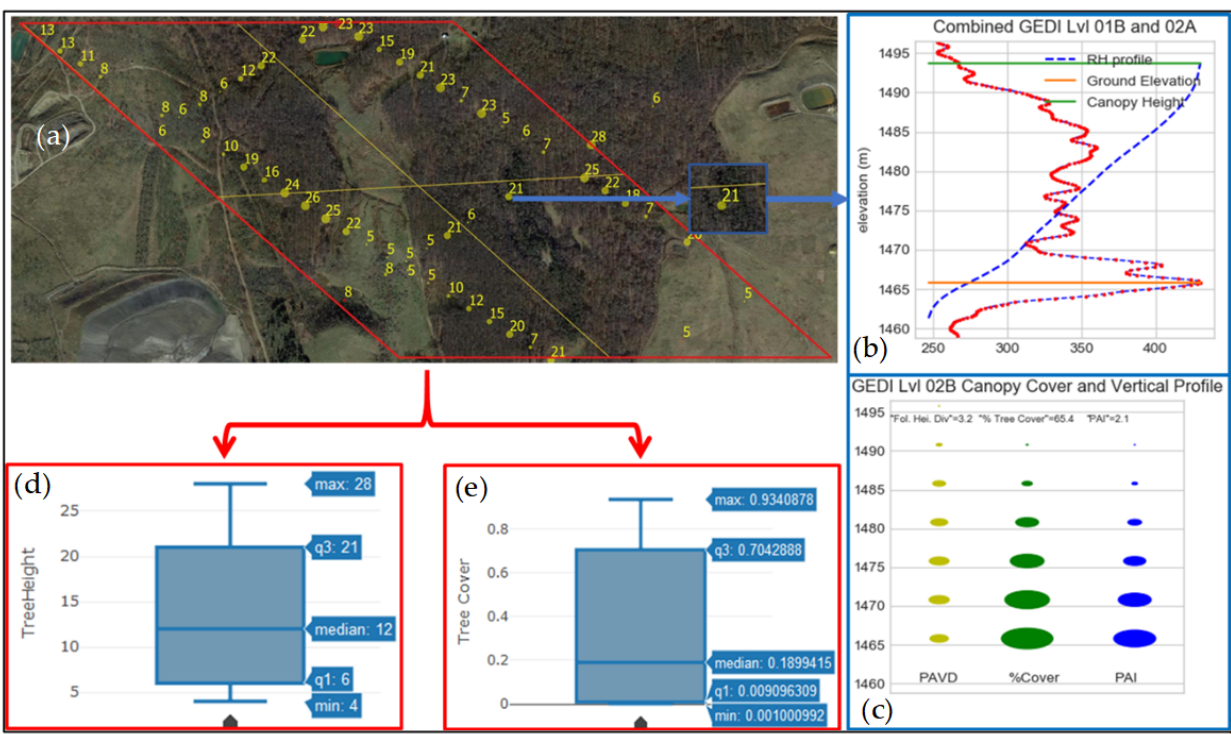
Figure 3. A graphical representation of the method used to calculate mean and median GEDI forest structure attributes with a VIIRS pixel. ( a ) Location of GEDI footprints (yellow points) collocated with a VIIRS pixel (red parallelogram), ( b ) GEDI waveform (red line) and the derived RH profile for a single GEDI footprint, ( c ) the GEDI-derived vertical profiles used in the calculation of percent tree cover (%cover), Plant area index (PAI), and foliage height diversity (FHD), ( d ) derived tree height statistics from the collocated GEDI footprints, and ( e ) derived tree cover statistics.